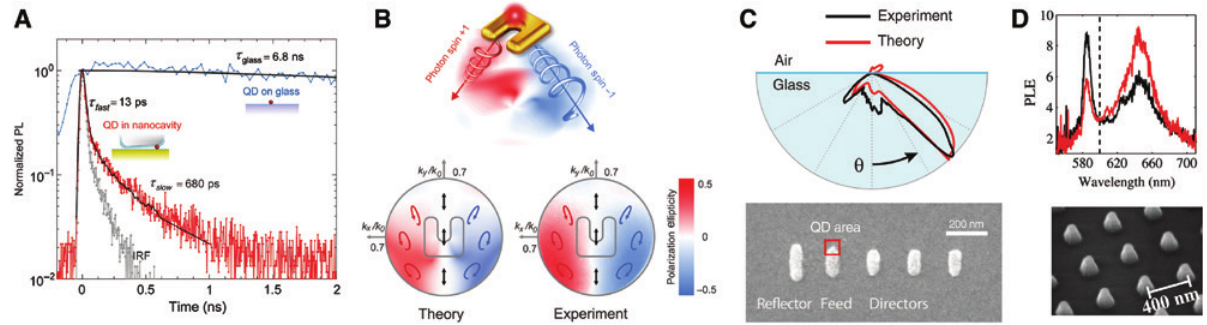
Figure 15: Emission engineering at the level of individual plasmonic